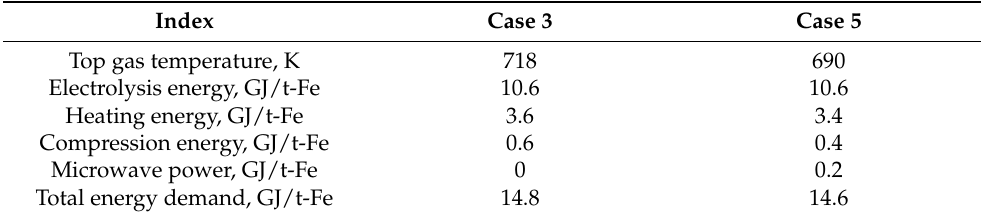
Table 4. Predicted performance indices of two cases studied in this work.